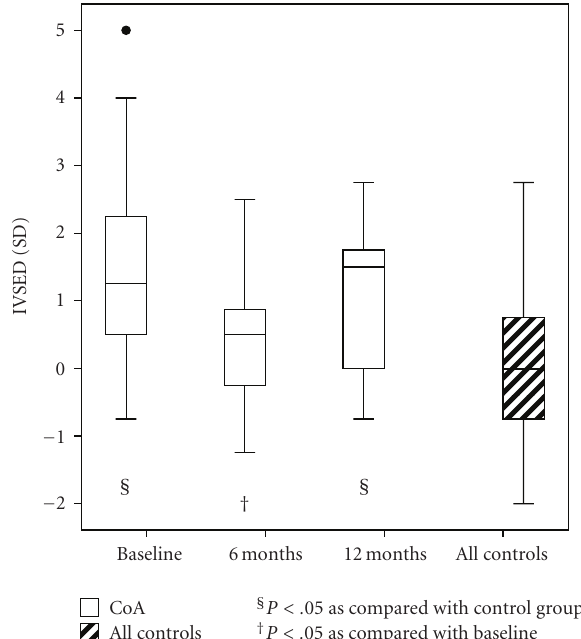
Figure 4: The z -score (SD) of end-diastolic thickness of interven- tricular septum (IVSED) in patients with coarctation of the aorta (CoA) and in controls. Whiskers at the top and bottom of each box indicate maximum and minimum; the top and bottom of each box the third and first quartiles; line through the box the median. Solid circle is an